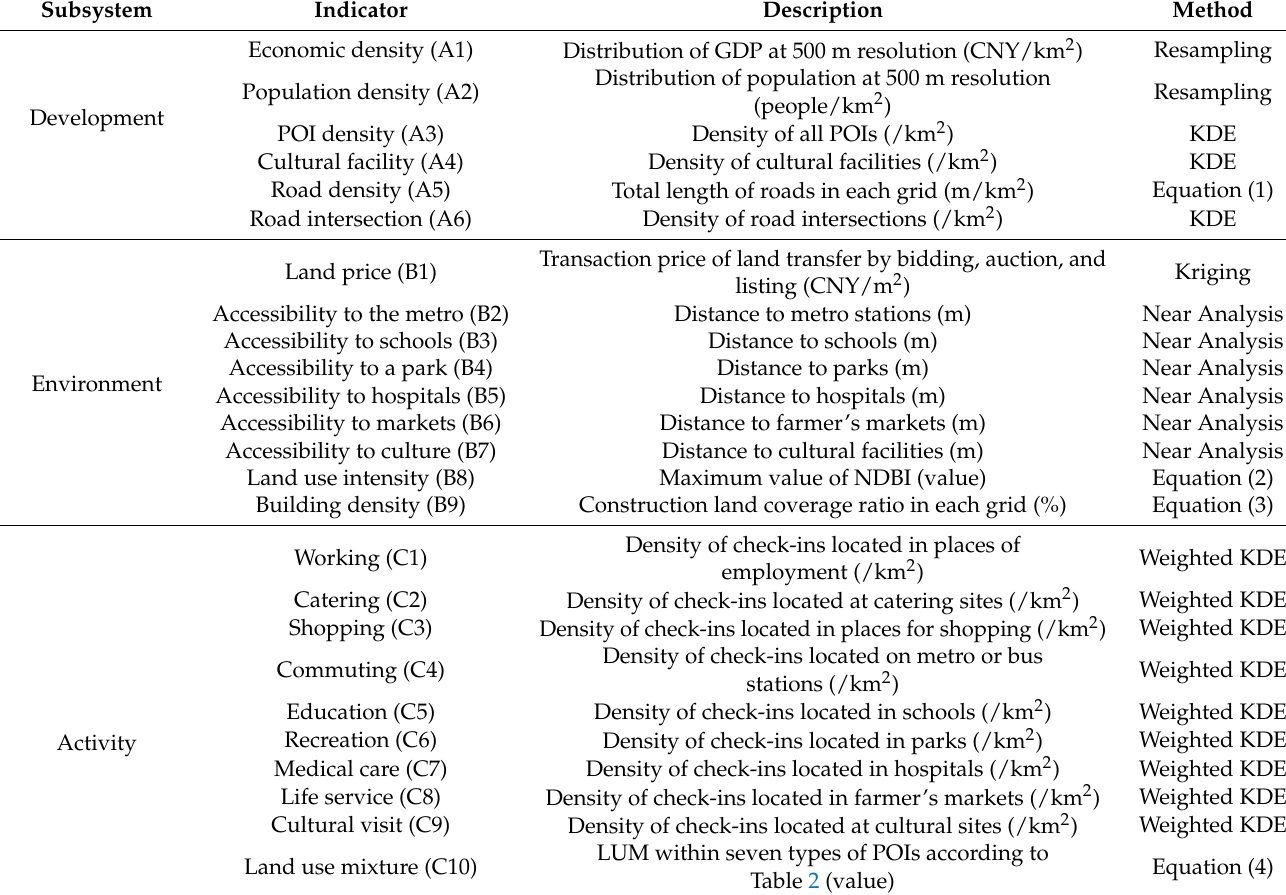
Table 3. Description and quantitative method of indicators for evaluating urban